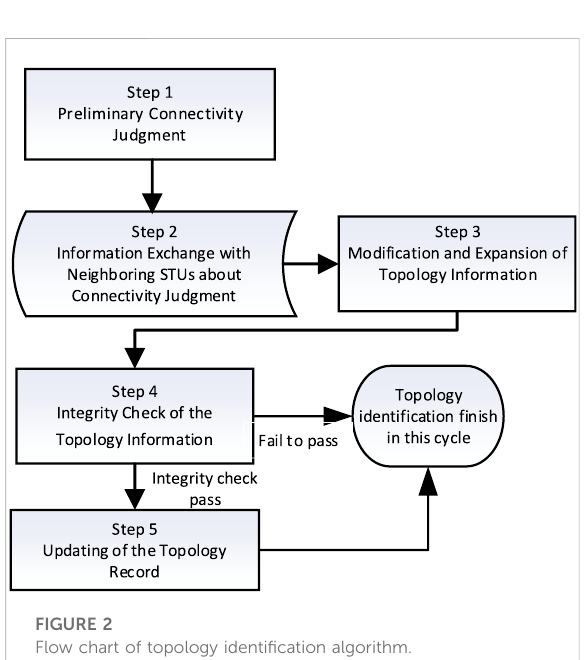
FIGURE 2 Flow chart of topology identi fi cation